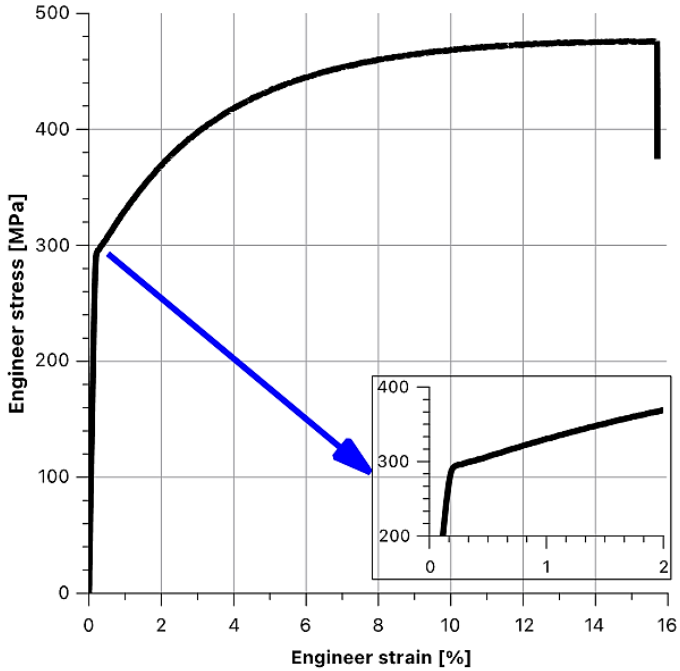
Figure 19. Steel insert material tension test. On the basis of the measured values, a bilinear elasto-plastic model was adopted, and the longitudinal modulus of elasticity was determined at the level of E = 204 GPa, E (cid:48) = 5.5 GPa. The E (cid:48) modulus was determined in the deformation range from 0.2% to 2%, as composite samples were tested in a similar